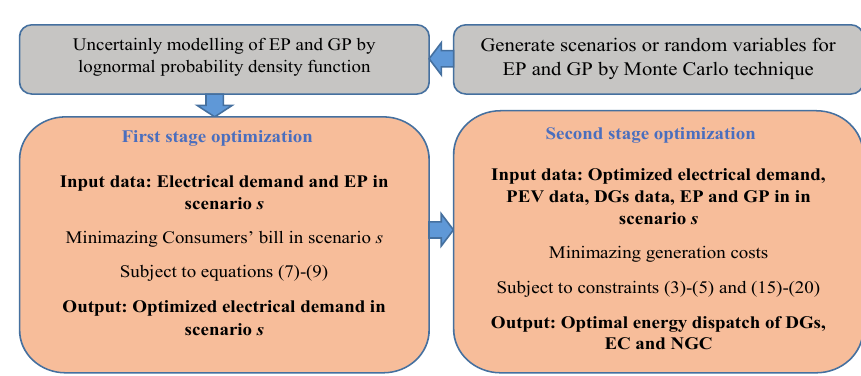
Fig. 2. 15-node test system.